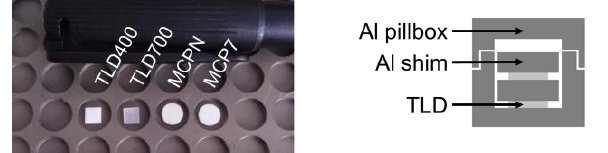
Fig. 1. Left: TLDs. Right: simplified schematics of the sensors in an aluminium pillbox. The reader system is a Harshaw 3500. For each sensor, two temperature profiles for the readout phase were used. The first is the one recommended by the constructor. The second one is a test law, in order to emphasize possible modifications in the luminescence curves after the irradiations. Readout parameters are presented in Table I and illustrated in Fig.